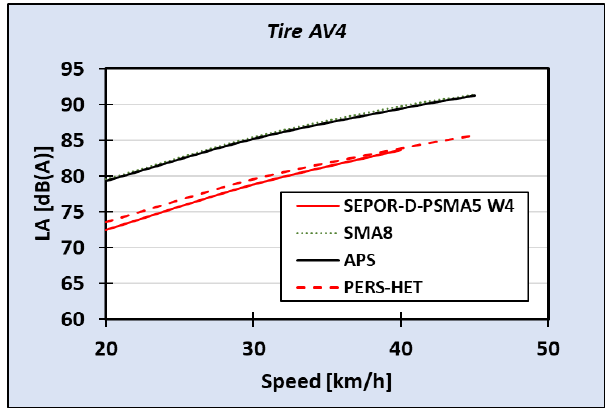
Figure 35. Results of laboratory tire/road noise measurements for tire SRTT.